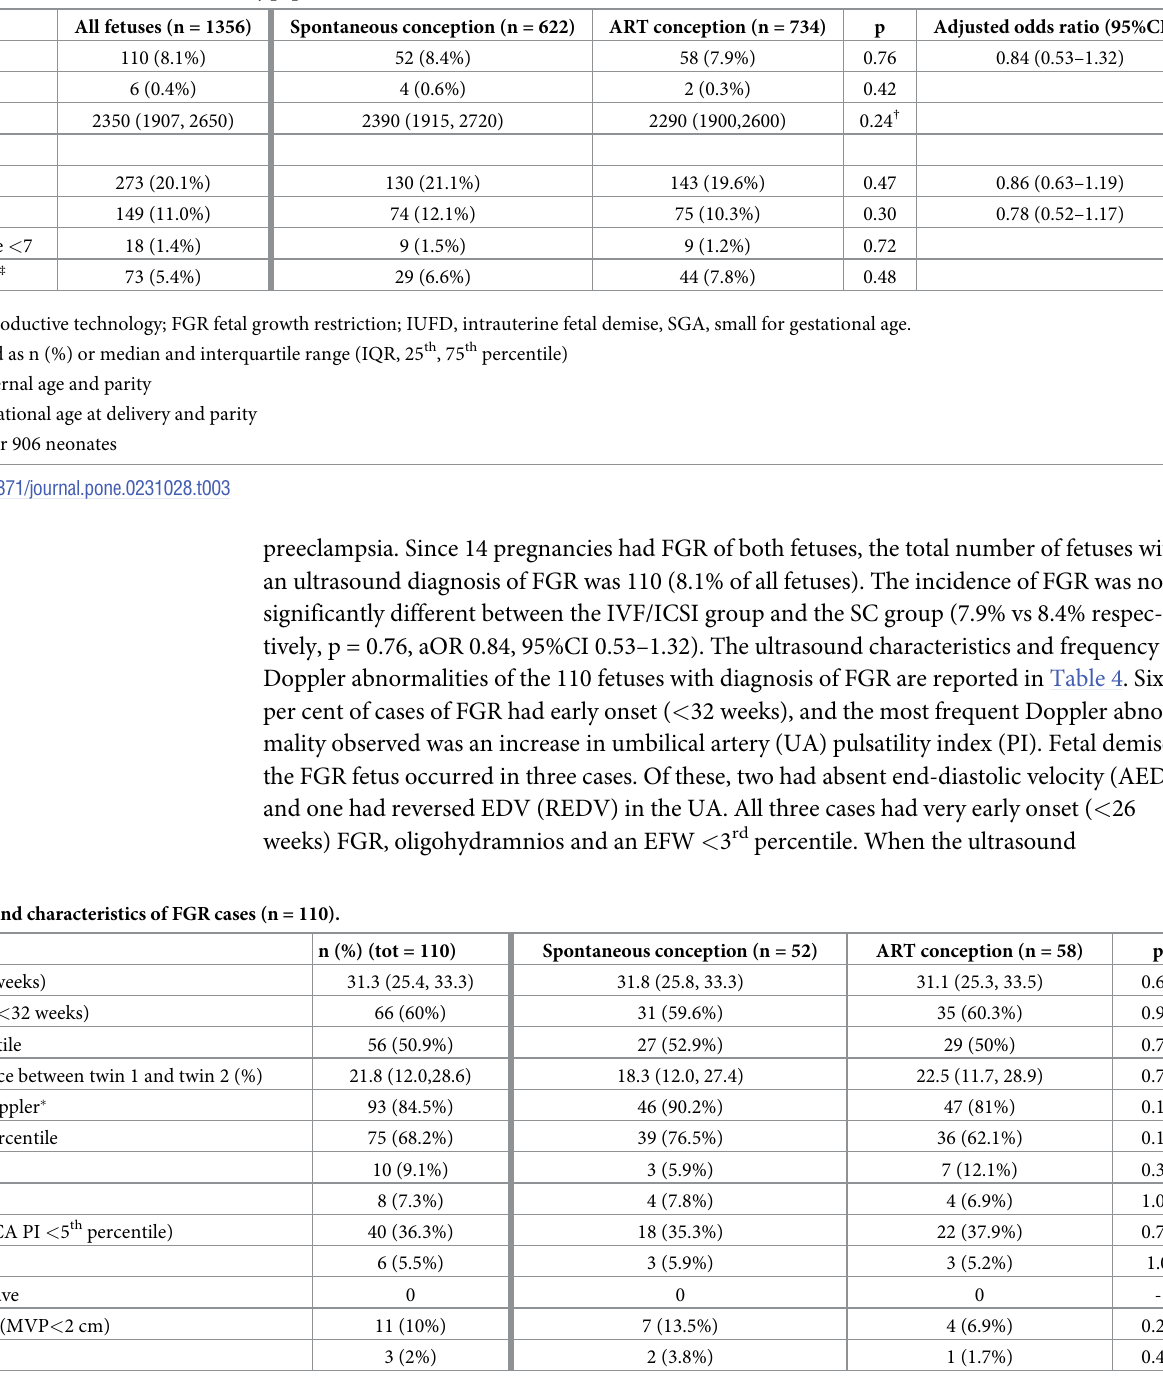
Table 3. Fetal and neonatal outcomes in the study population.